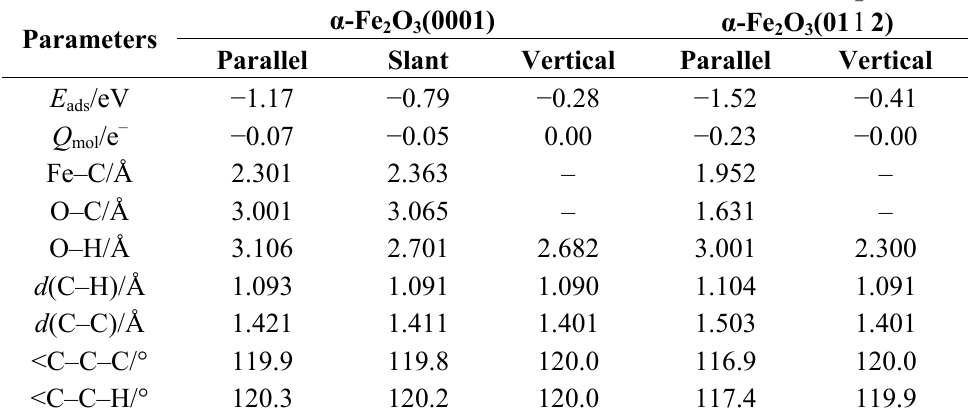
Table 4. Adsorption energies and structure parameters of benzene adsorbed on the (0001)  and (01 1 2) α-Fe O surfaces. E and Q denote respectively the adsorption energy and 2 3 ads mol charge on the adsorbed benzene